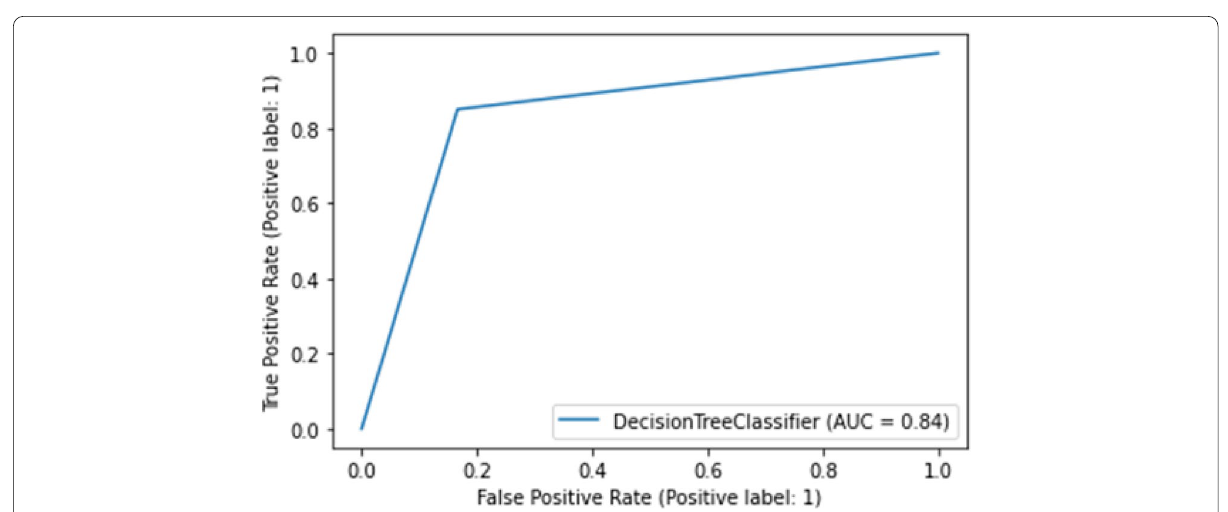
Fig. 4 Receiver operating characteristic curve for validation